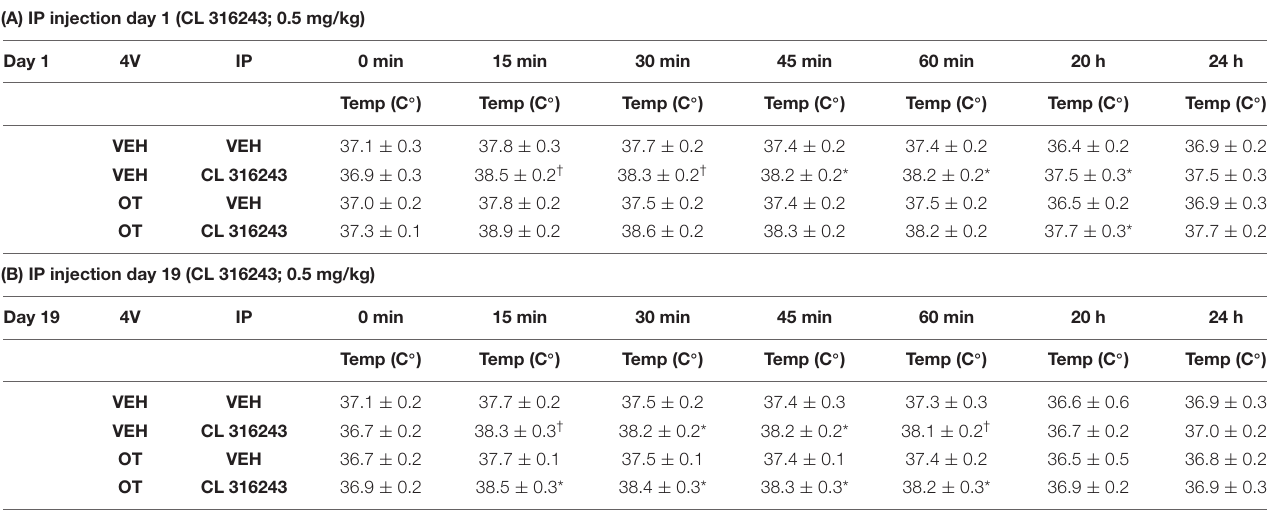
TABLE 4 | T IBAT measurements following acute systemic administration of the beta-3 receptor agonist (CL 316243) or vehicle in male DIO rats. (A) IP injection day 1 (CL 316243; 0.5